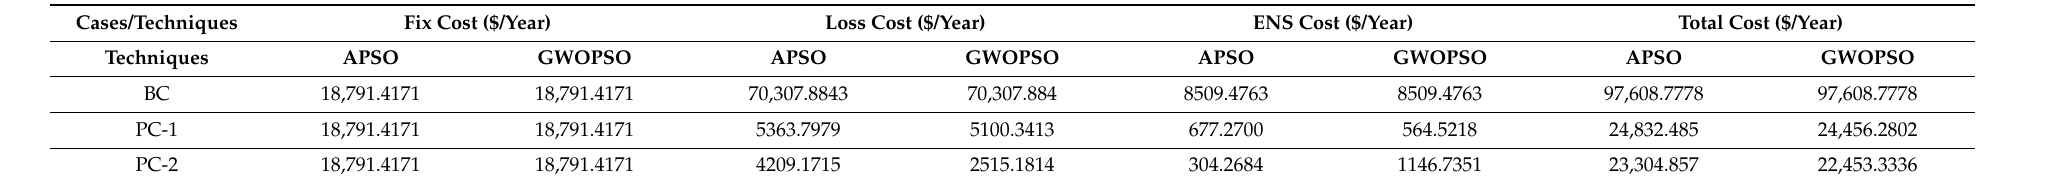
Table 8. Different cost of the IEEE 33 bus